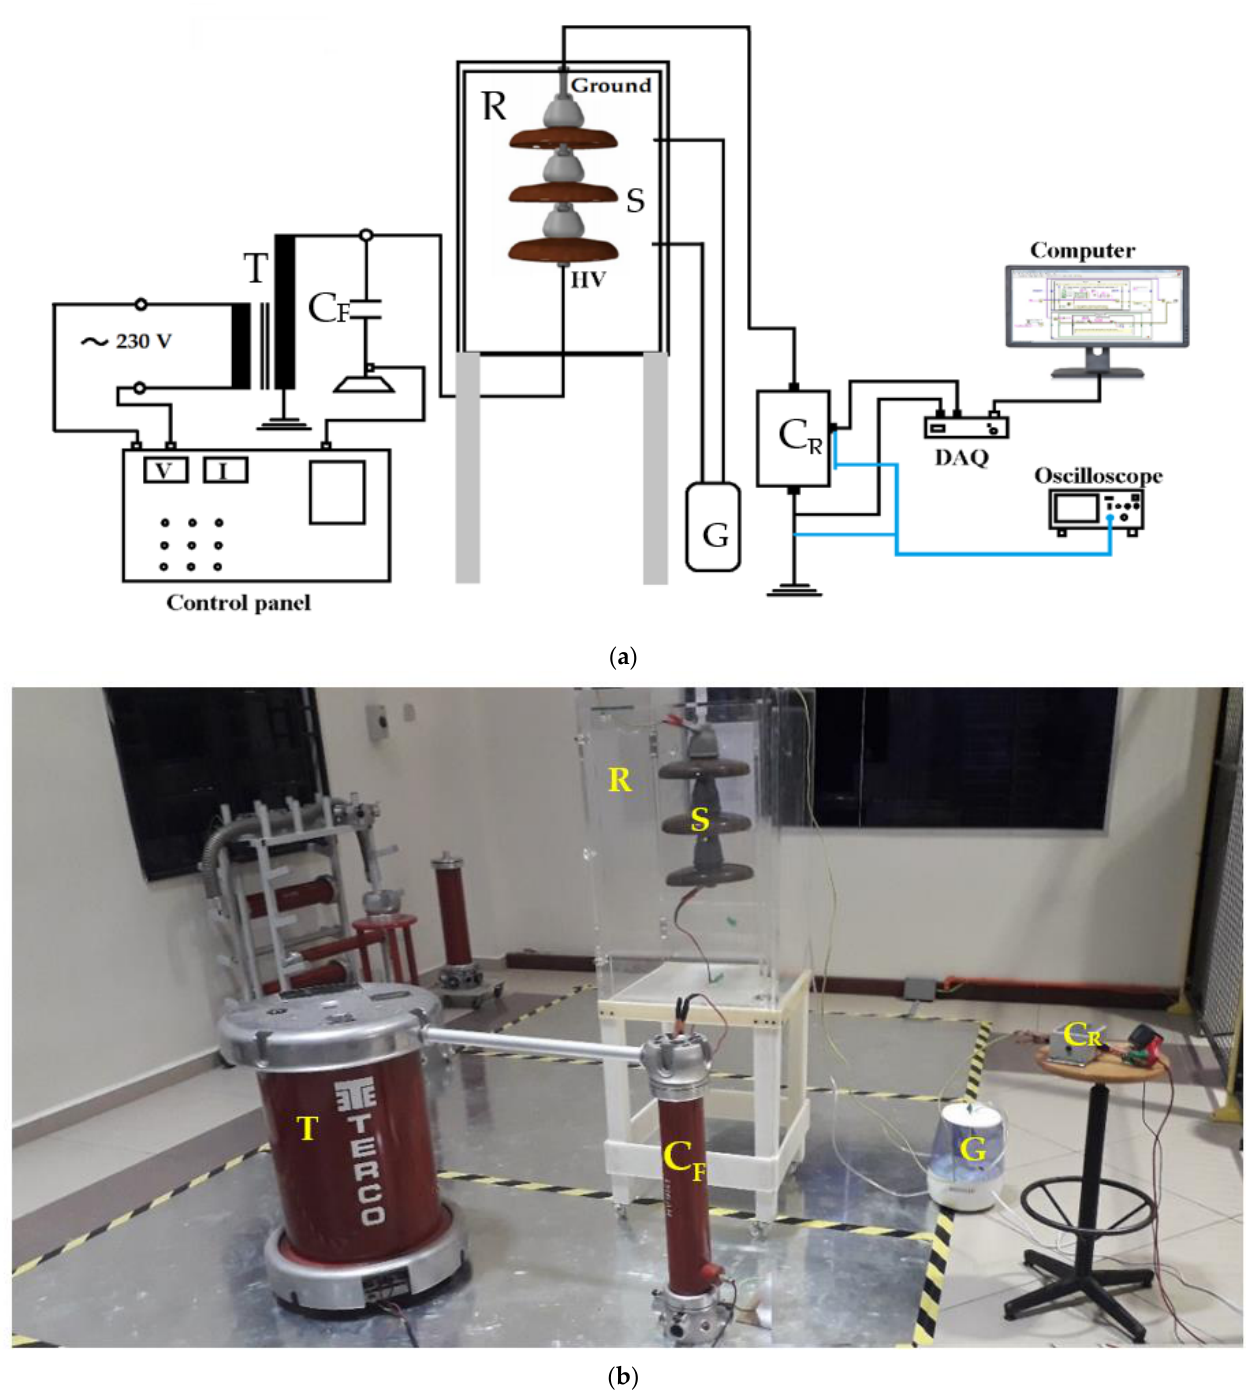
Figure 5. ( a ) Experiment setup schematic diagram. ( b ) Pictorial view of the test setup. Table 2. RTV coating material technical